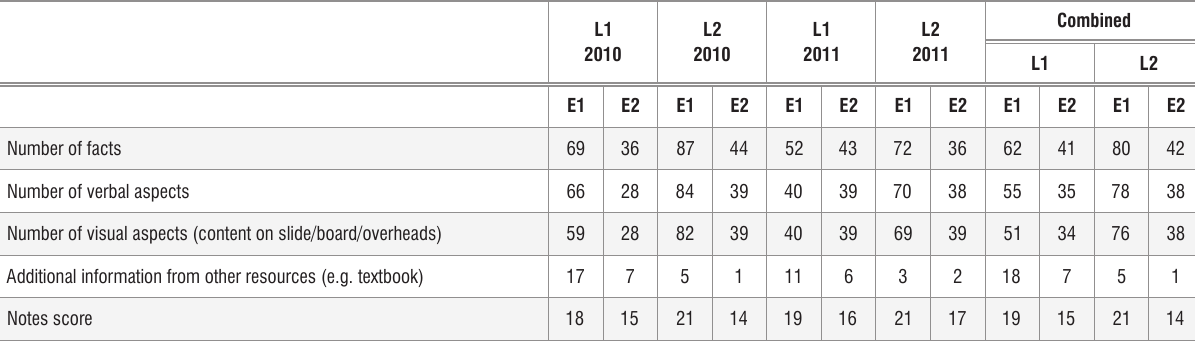
Comparison of Semester 1 note-making averages between first- and second-language students